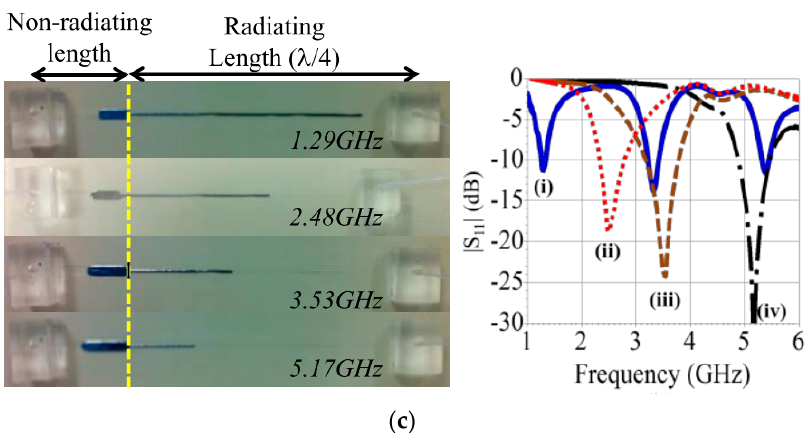
Figure 8. ( a ) Design of frequency reconfigurable monopole fluidic antenna with mercury as the fluid; ( b ) exploded view of antenna layers; ( c ) fabricated antenna and corresponding frequency response [23].